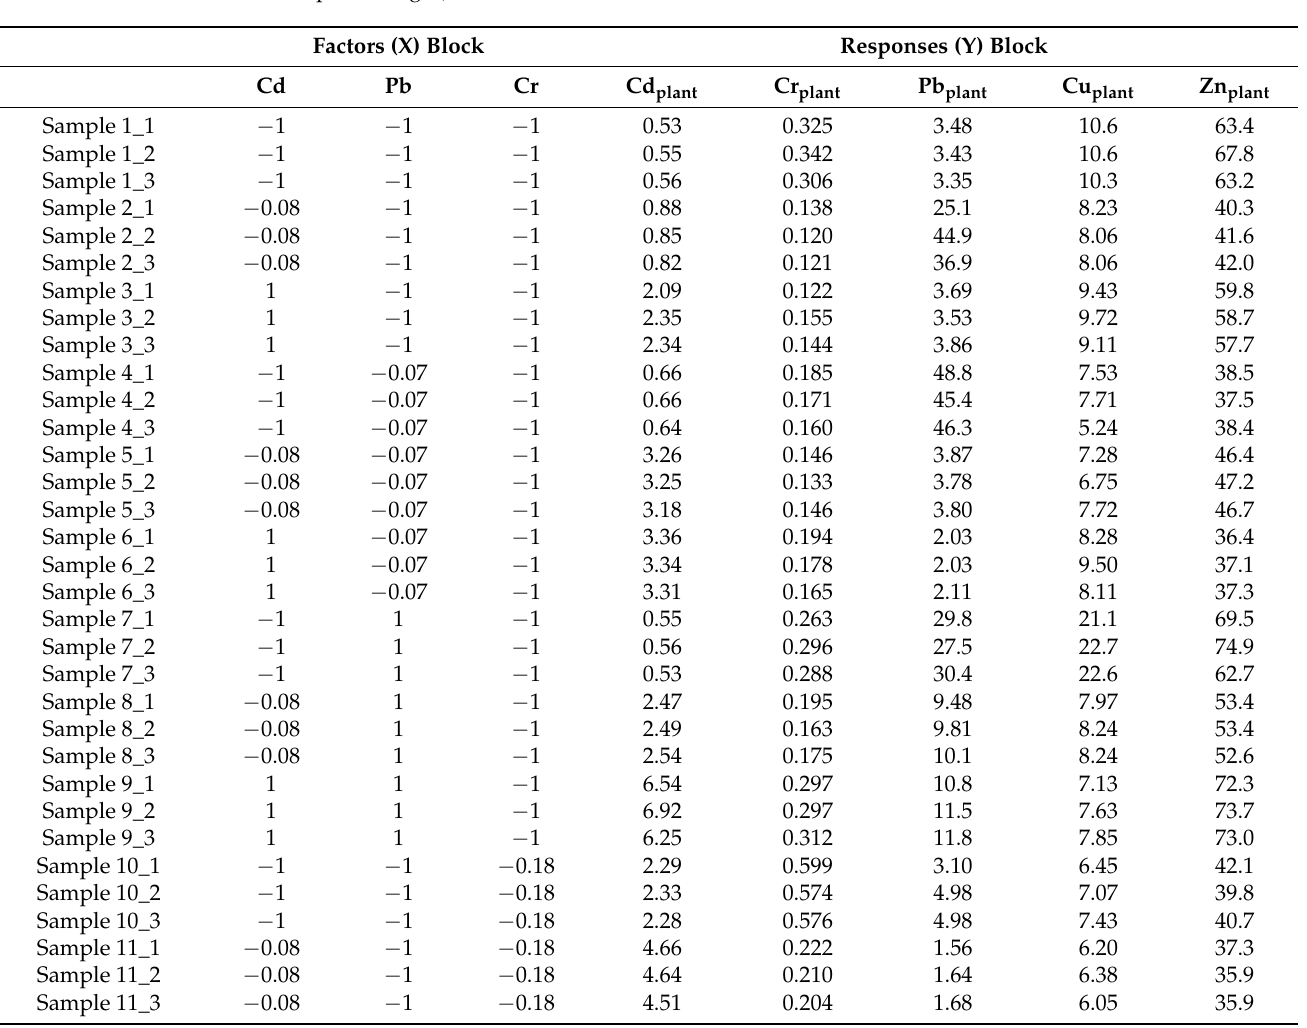
Table A1. DoE table. Factor levels are the ones reported in Table 1. Cu and Zn had fixed